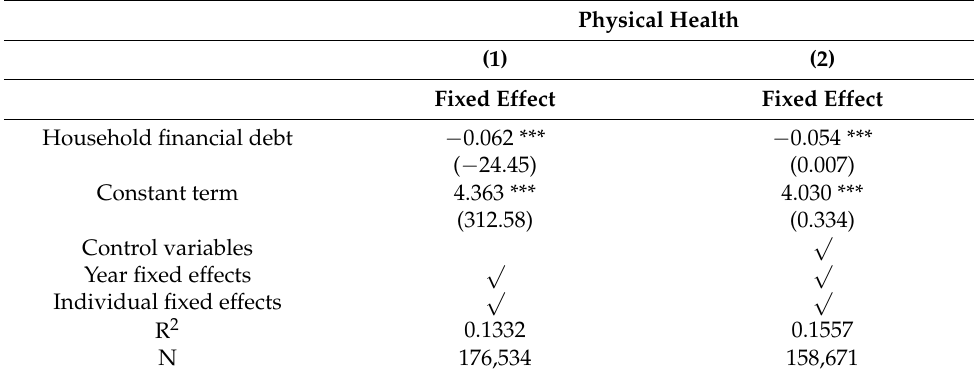
Table 2. Regression results of household financial debt on physical